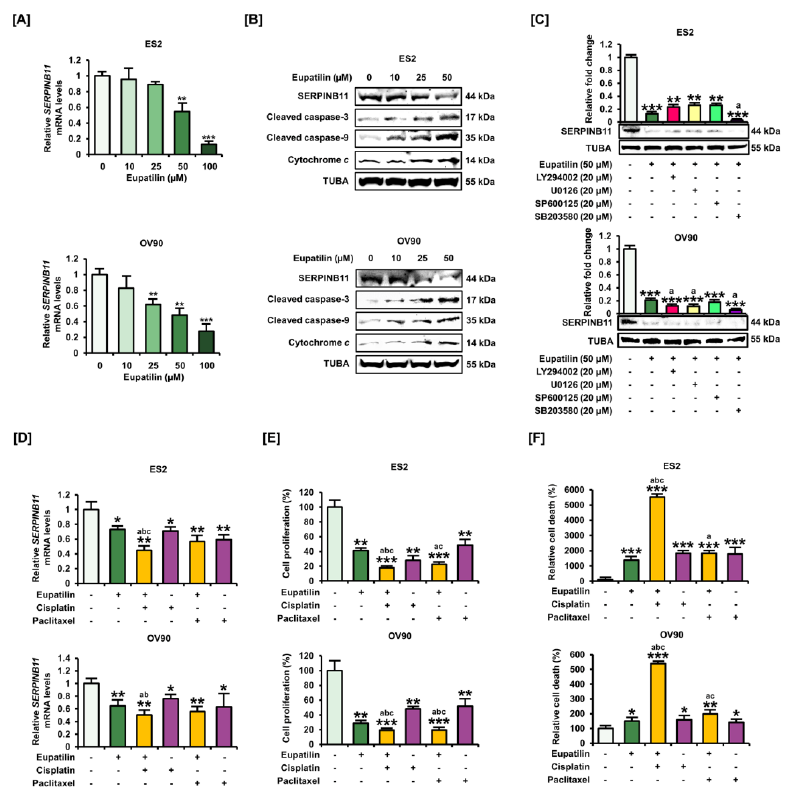
Figure 5. Functional role in SERPINB11 in ovarian cancer treated with eupatilin. ( A ) Dose-dependent e ff ects of eupatilin on SERPINB11 mRNA expression levels in ovarian cancer cells were determined by quantitative RT-PCR analysis. ( B ) Expression levels of SERPINB11 and apoptosis-related proteins according to eupatilin dosage in ES2 and OV90 cells. ( C ) Expression of SERPINB11 protein was evaluated with each pharmacological inhibitor in eupatilin-treated ovarian cancer cells. ( D ) The mRNA expression of SERPINB11 according to the separate or combined use of eupatilin, cisplatin, and paclitaxel in ES2 and OV90 cells. ( E ) The synergistic inhibition of cell proliferation in response to the combination of eupatilin with cisplatin or paclitaxel in ES2 and OV90 cells. ( F ) The synergistic induction of cell death in response to the combination of eupatilin with cisplatin or paclitaxel in ES2 and OV90 cells. The experiments were performed in triplicate. Data represent the mean ± standard deviation, and asterisks indicate that the e ff ect of treatment was statistically significant (* p < 0.05, ** p < 0.01, and *** p < 0.001). Lowercase letters indicate statistically significant ( p < 0.05) e ff ects of treatments: a, compared with eupatilin alone; b, compared with cisplatin alone; and c, compared with paclitaxel alone. Detailed information about the western blot can be found in Figure